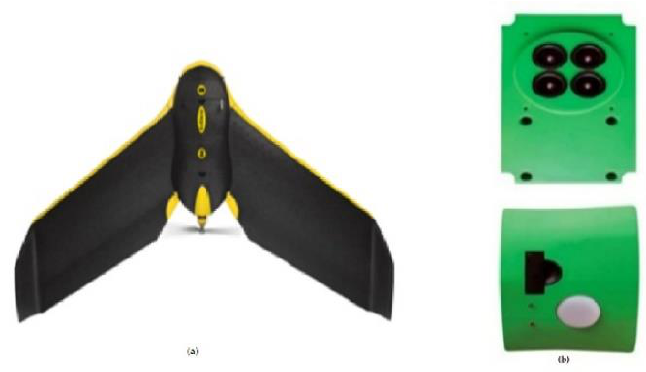
Table 2. Characteristics of UAV’s flight missi ons during different stages of wheat growth.